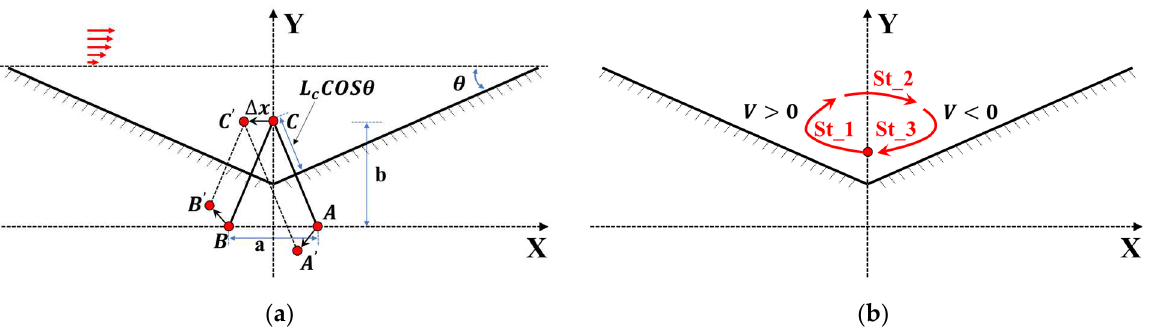
Figure 11. Kinematic analyses of boundary vortices when AR > 2.15. ( a ) Coordinates of boundary vortex and image vortices; ( b ) moving path of boundary vortex.